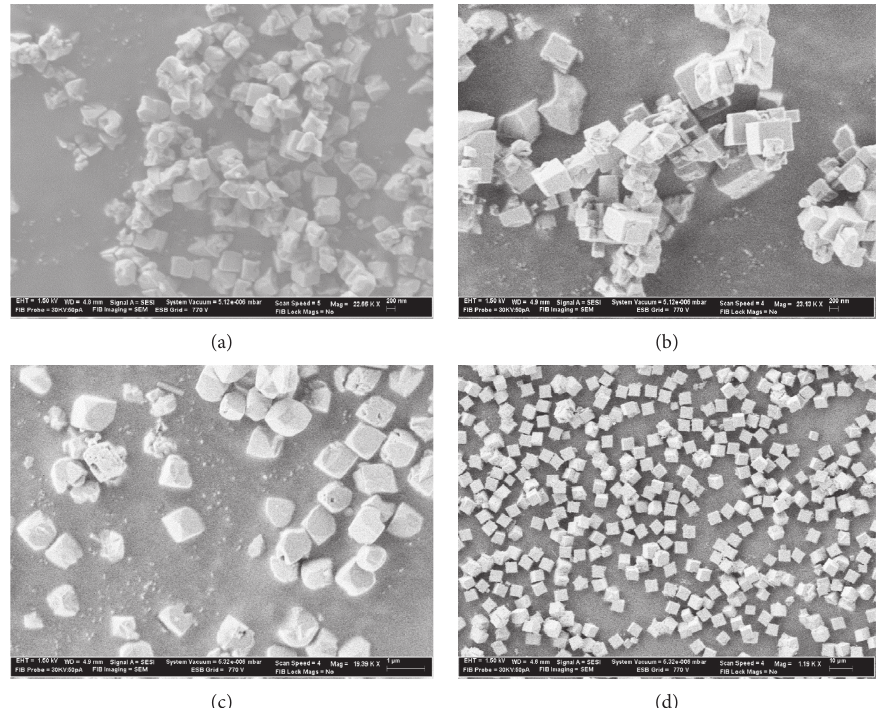
Figure 3: SEM images of CHA zeolites prepared by the transformation of CBV100 ((a), sample #1), CBV712 ((b), sample #3), MFI ((c), sample #11), and LTL ((d), sample #13).